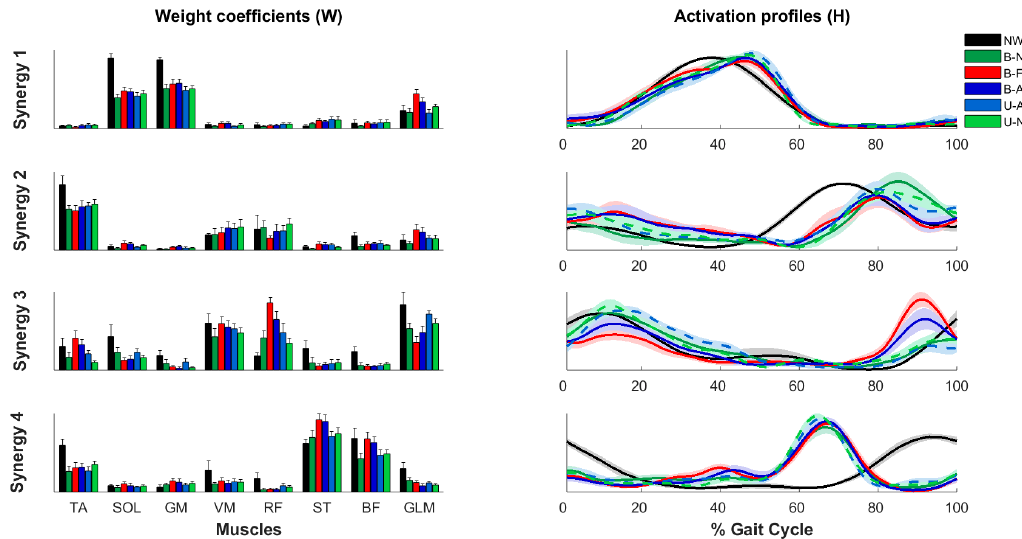
Figure 8. Weights (left panel) and activation coefficients (right panel) of the four muscle synergies when normal walking without the Ekso and when walking with the Ekso: B-NA, B-FA, B-AA, U-AA, and U-NA. Colors and lines indicate the different walking modalities: black solid line for normal walking without the Ekso (NW); the other colors refer to walking with the Ekso with bilateral no assistance (B-NA, dark green solid line), bilateral full assistance (B-FA, red solid line), bilateral adaptive assistance (B-AA, dark blue solid line), unilateral adaptive assistance (U-AA, light blue dotted line), and unilateral no assistance (U-NA, light green dotted line).